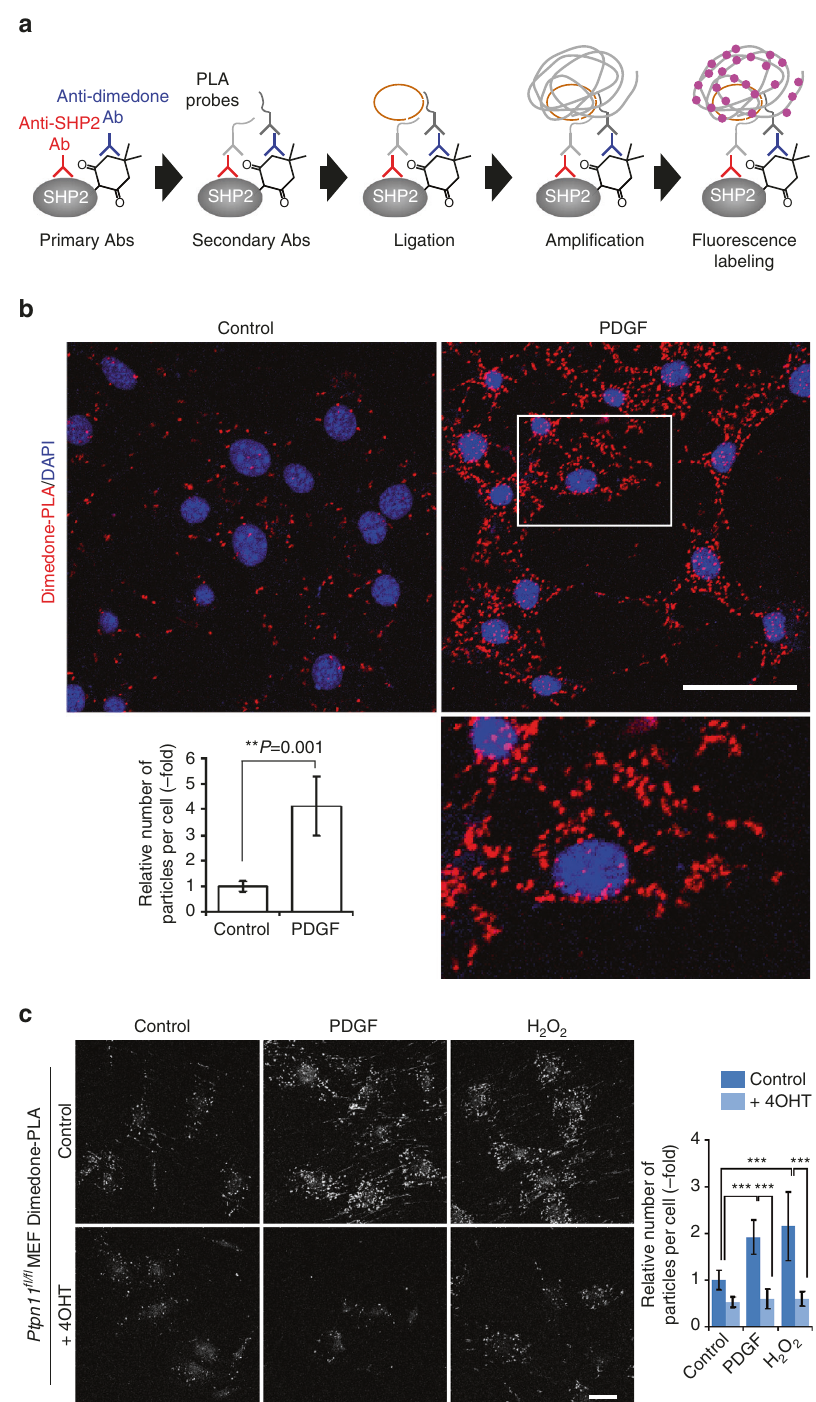
Fig. 1 Detection of oxidized SHP2 by dimedone-PLA. a Schematic illustrating method for detecting oxidized SHP2 by dimedone-PLA. b Serum-starved Swiss 3T3 cells were stimulated with PDGF-BB (50 ng ml − 1 ) for 10 min or left unstimulated. Cells were fi xed in the presence of dimedone (5 mM) for 5 min, and subjected to dimedone-PLA ( red ). Nuclei were stained with DAPI ( blue ). Representative images are shown for each condition from one of > 4 independent biological replicates. A higher magni fi cation image of the boxed region is shown at the bottom right . The graph shows the average number of PLA signals per cell ( n = 6 images for each condition, 5 – 20 cells in an image), relative to control cells without stimulation (set as 1). The P -value was calculated using a two-tailed Welch ’ s t -test. Error bars represent SD. c Serum-starved Ptpn11 fl / fl MEFs expressing CRE-ER Tam treated with or without 4-hydroxytamoxifen ( 4OHT ) were stimulated with PDGF-BB (50 ng ml − 1 ) or H 2 O 2 (1 mM) for 10 min. Cells were fi xed in the presence of dimedone, and subjected to dimedone- PLA ( gray ). Representative images are shown for each condition from one of three independent experiments. The graph shows average number of PLA signals per cell ( n = 6 images for each condition, 5 – 20 cells in an image), relative to control cells without stimulation (set as 1). *** P < 0.0001, ANOVA with Bonferroni/Dunn ’ s post-hoc test. Error bars represent SD. Scale bars : 50 μ m